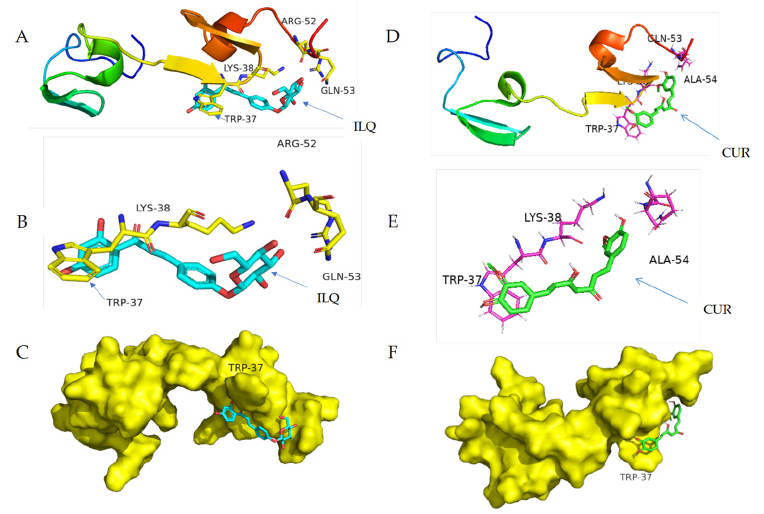
Figure 6. Molecular docking of HIV ‐ NCp7 ZF with ILQ and CUR: ( A , D ) overview, ( B , E ) zoom in of the stacking region and ( C , F ) surface of the protein with ILQ and CUR, respectively.